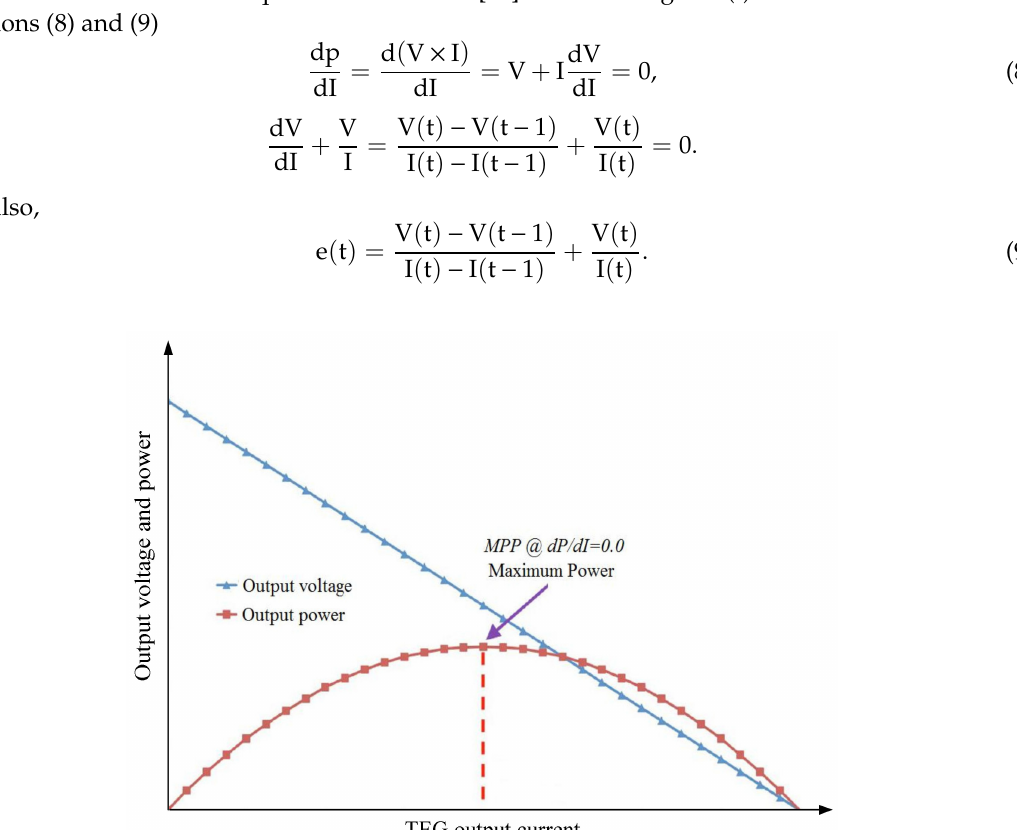
Figure 5. TEG electrical